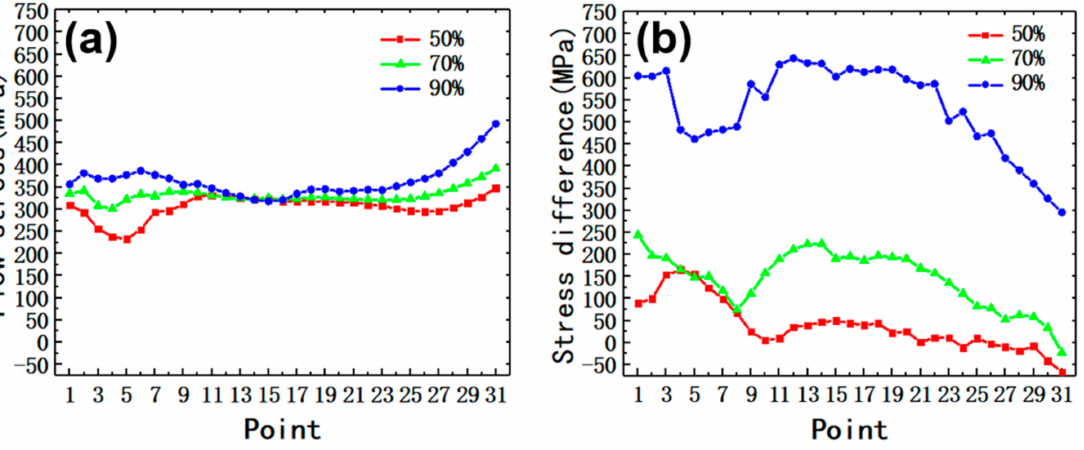
Figure 18. ( a ) The flow stress of AISI 1045 steel; ( b ) the difference between radial stress and flow stress of AISI 1045